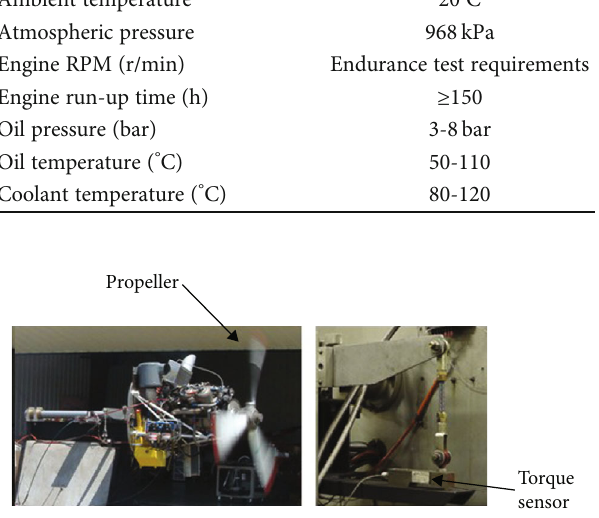
Figure 17: The engine endurance